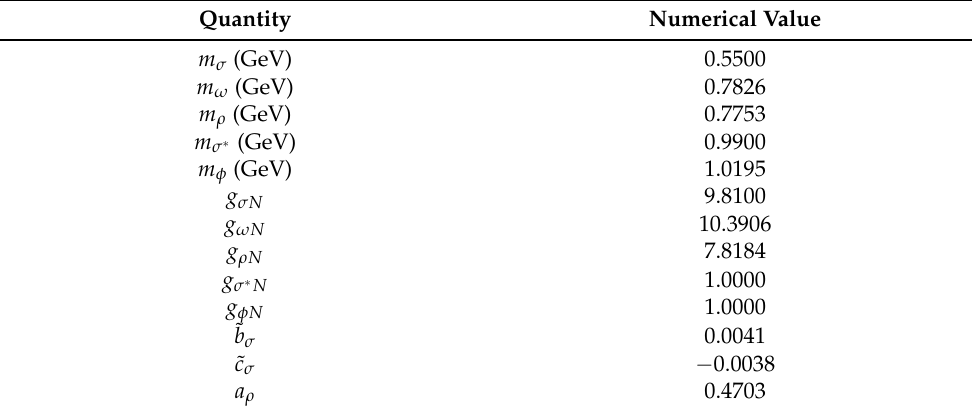
Table 1. Parameters of the SW4L parametrization that lead to the properties of symmetric nuclear matter at saturation density shown in Table 2.